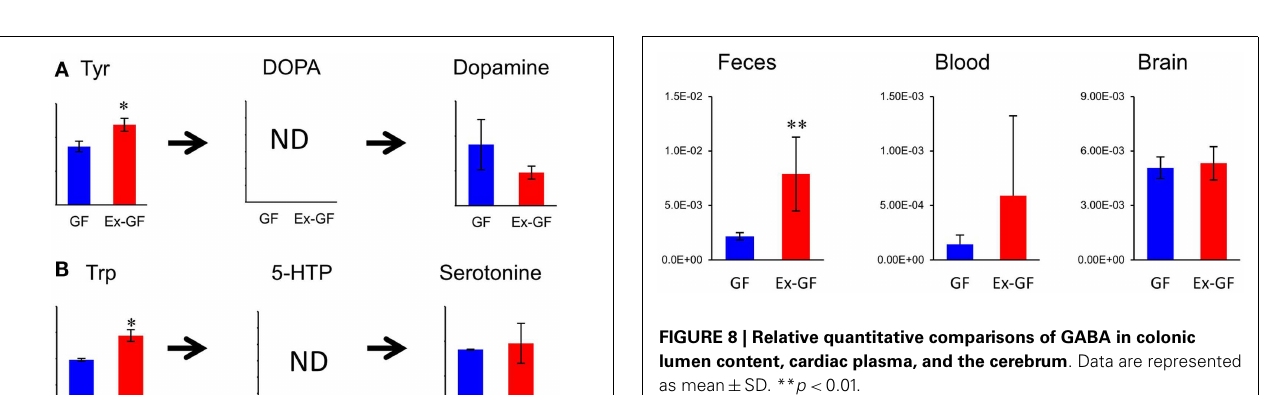
FIGURE 6 |Aggregate microbiota composition at the phylum and family levels in the colonic content of Ex-GF mice .